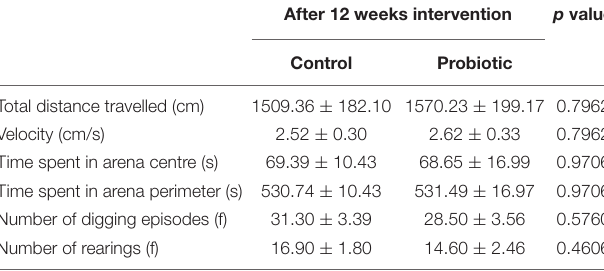
TABLE 1 | Open field testing.